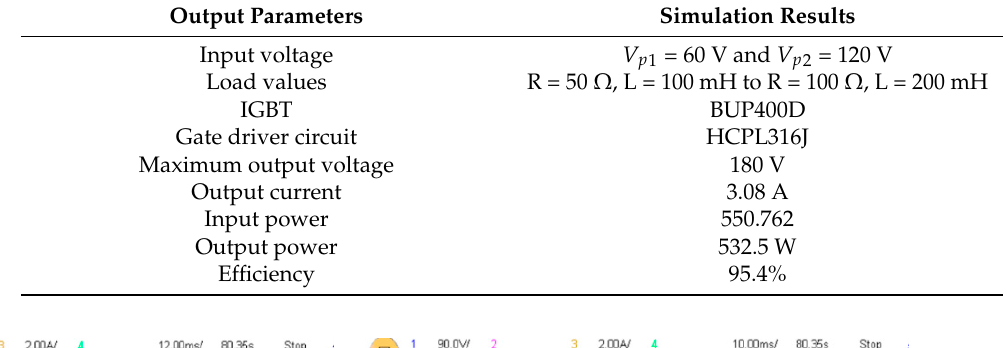
Figure 11. Photograph of laboratory experimental setup for proposed MLI. Table 4. Important parameters with experimental results.